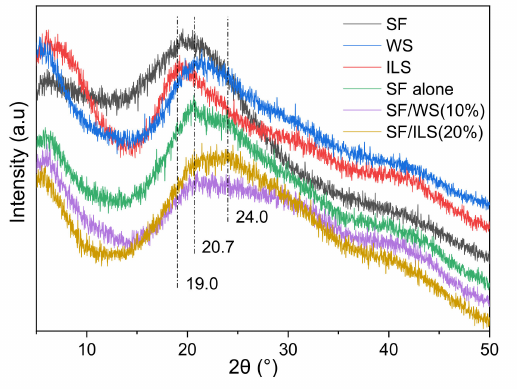
Figure 7. X-diffraction patterns of SP powder and SF scaffold and their SP composite scaffolds. SF, WS, and ILS were freeze-dried powder samples of silk fibroin, whole silk fibroin, and inner silk fibroin, respectively; SF alone, SF/WS (10%), and SF/ILS (20%)